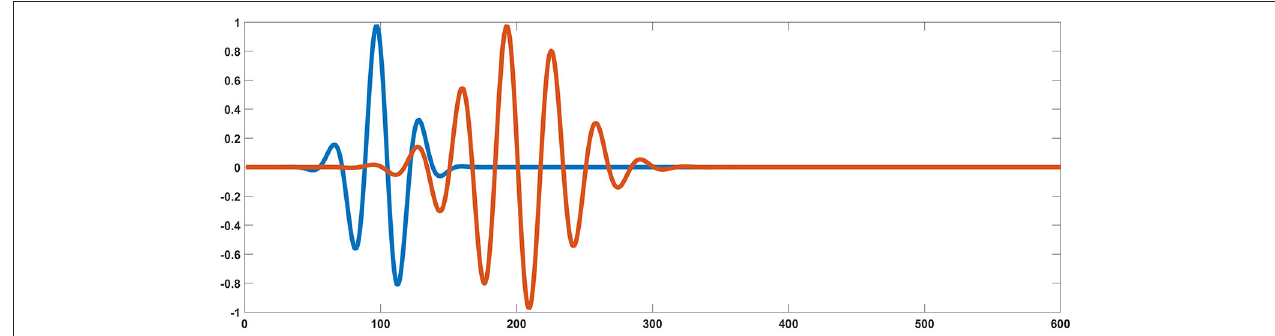
FIGURE 2 | Simulated signal generated from two coherent sources (blue and orange). Based on the source settings, simultaneously collected simulated surface MEG and EEG recordings could be derived by solving an electromagnetic forward problem.